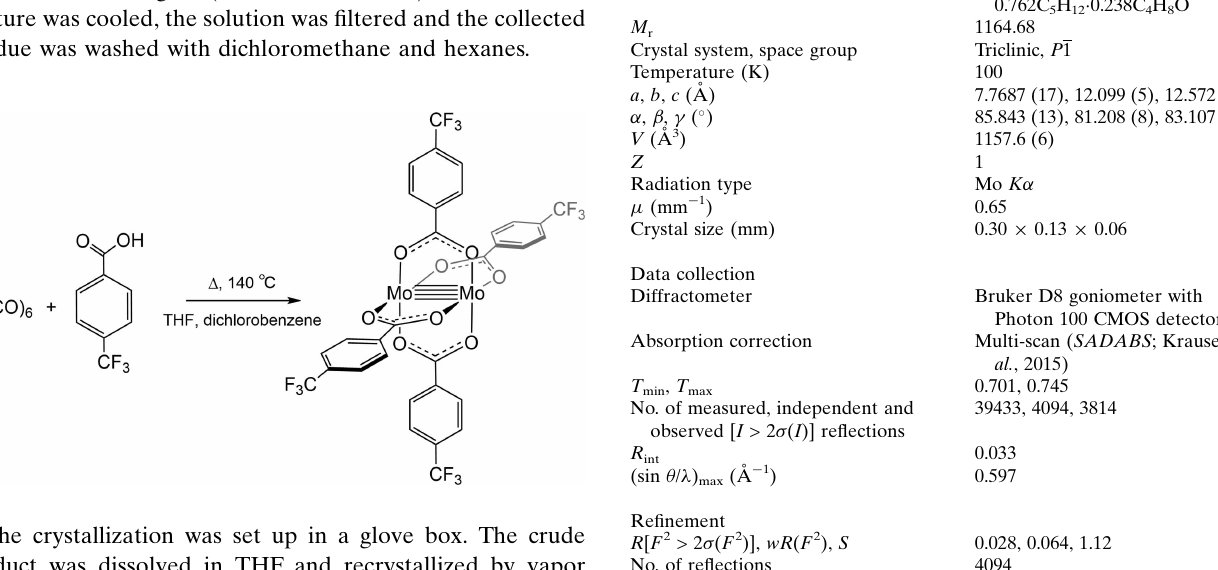
Table 2 Experimental details. Crystal data Chemical